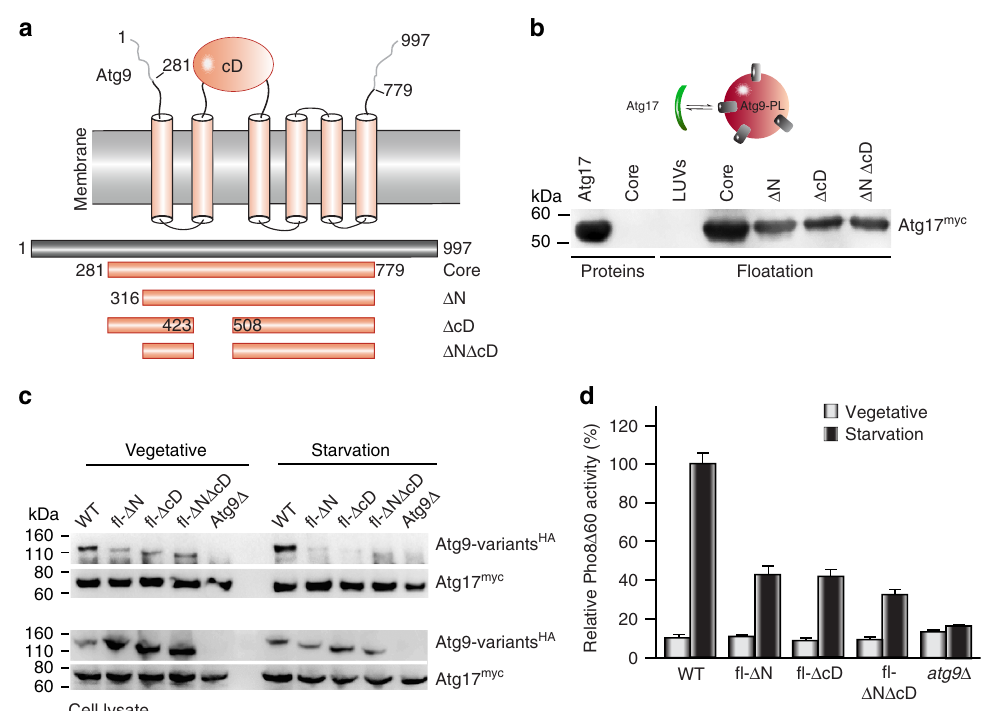
Figure 2 | Cytoplasmic domains of Atg9 interact with Atg17 to promote autophagy. ( a ) The scheme shows the topology of Atg9 in membranes (transmembrane domains, pink cylinders; membrane bilayer in grey; cD, cytoplasmic domain). The grey bar represents Atg9 WT , the pink bars illustrate Atg9-variants with corresponding domain borders indicated by numbers. ( b ) a -myc immunoblot of co-floatation assays of Atg9-PL, containing Atg9 core or its variants, with Atg17. Large unilamellar vesicles (LUVs) lacking Atg9 served as a control for unspecific membrane binding. Proteins, recombinant Atg17 and Atg9–PLs used for experiments. ( c ) Immunoprecipitation (IP) of Atg17 myc from ATG9 WT , ATG9 D N , ATG9 D cD , ATG9 D N D cD and ATG9 D lysates under vegetative conditions and after 2h of starvation. Atg9 -variants contained the very N- (1–280) and C-terminal (779–997) unstructured regions, which were not present in Atg9 core (indicated by the prefix fl), because these regions are essential for proper trafficking of Atg9 in vivo 10,49,50 . Atg17 and co-immunoprecipitated Atg9-variants were detected by a -myc and a -HA immunoblots as indicated. Atg17 strongly interacts with wild-type Atg9, but not with Atg9 lacking N-, cD- or both domains. Bottom panel: total protein amounts in cell lysates. ( d ) Pho8 D 60 assay of vegetative (white bars) and starved (black bars) ATG9 WT , ATG9 D N , ATG9 D cD , ATG9 D N D cD and ATG9 D . The Pho8 D 60 activity of starved ATG9 WT was set to 100% and used for normalization. Mean values ± s.d. of N ¼ 3 independent experiments are